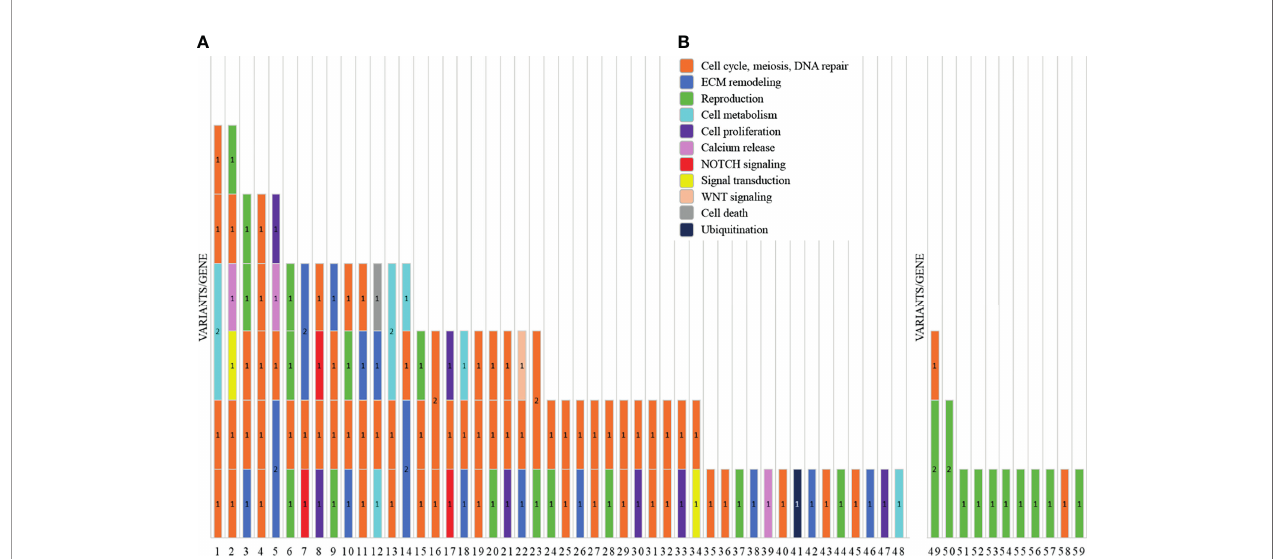
FIGURE 1 | Graph representations of the number of variants identi fi ed by NGS analysis in two subgroups of primary ovarian insuf fi ciency (POI) patients. For each patient, indicated are the ID number ( x -axis) and the number of variants/genes found altered (1 = 1 variant/gene; 2 = 2 variants/gene). Each color represents a different pathway: cell cycle, meiosis, and DNA repair (orange); ECM remodeling (blue); reproduction (green); cell metabolism (cyan); cell proliferation (purple); calcium release (pink); NOTCH signaling (red); signal transduction (yellow); WNT signaling (light orange); cell death (gray); and ubiquitination (dark blue). (A) The histogram reports the variants found by screening 295 candidate genes included in the OVO-Array panel. (B) NGS results of the analysis for diagnostic purposes of nine known POI